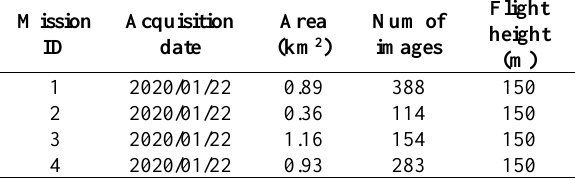
Figure 3. High-resolution orthophoto from mission 1 (a), mission 2 (b), mission 3 (c) and mission 4